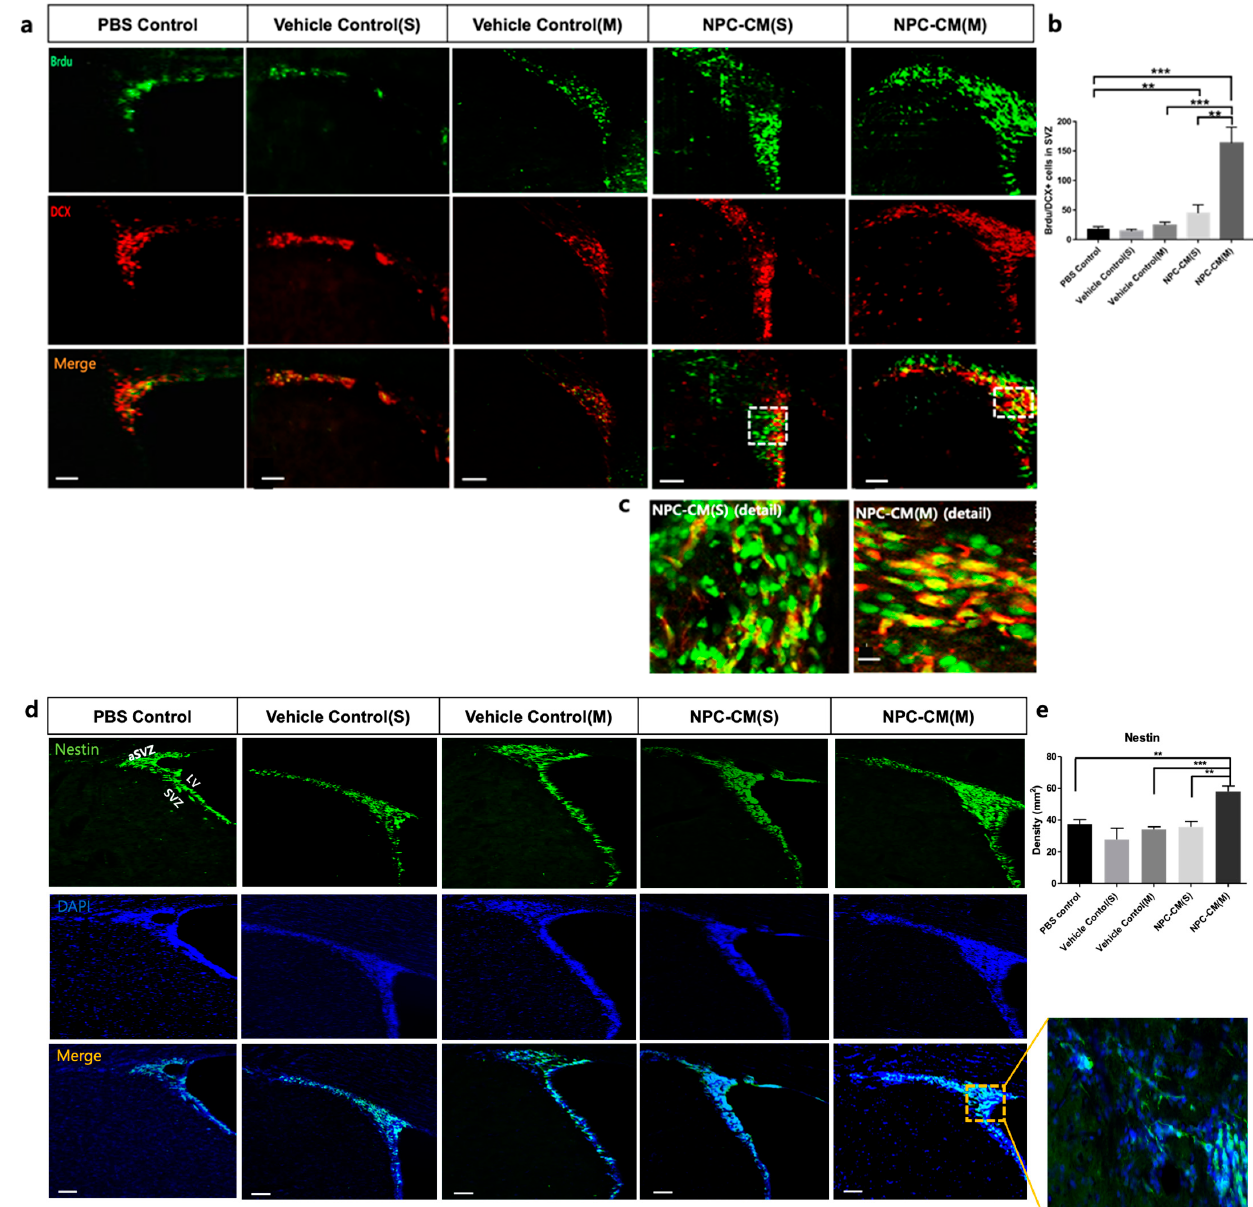
Figure 4. NPC-CM treatment increased endogenous neurogenesis at the ischemic lesion in the pMCAO. ( a ) Immunohistochemistry for BrdU (green) and Doublecortin (DCX) (red) of the rat brain from 15 days after pMCAO. n = 4 per group. Scale bar = 300 μ m (b) Quantification of BrdU/DCX dual-immunoreactive cells in SVZ from PBS control, vehicle control, NPC-CM(S), and NPC-CM(M). Bar graph revealing the quantification of cells positive for both BrdU and DCX in the SVZ ipsilateral to the ischemic injury. ( c ) Higher magnification of BrdU-labeled cells colocalized with DCX in SVZ (Scale bar = 30 μ m). ( d ) Nestin-expressing neural stem/progenitor cells in the SVZ were increased in rats treated with NPC-CM(M). Higher magnification of nestin+ cells in anterior subventricular zone (aSZV) of NPC-CM(M)-treated brain is shown. ( e ) Density of nestin cells per mm 2 in the SVZ ipsilateral to the ischemic injury is shown. Values are indicated as means ± SD., ** p < 0.01, *** p < 0.001, n = 4 per group. Scale bar = 300 μ m.